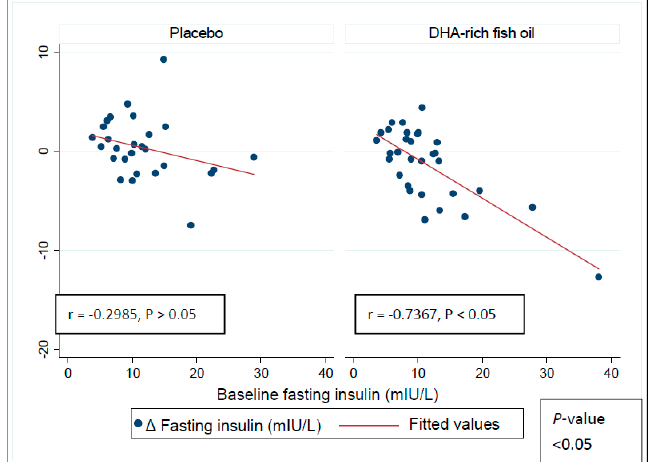
Figure 4. Pearson’s product–moment correlations exhibiting relationship between baseline fasting insulin values and responses to intervention in the placebo and the DHA-rich fish oil groups. p -value represents differences in correlations between the groups.